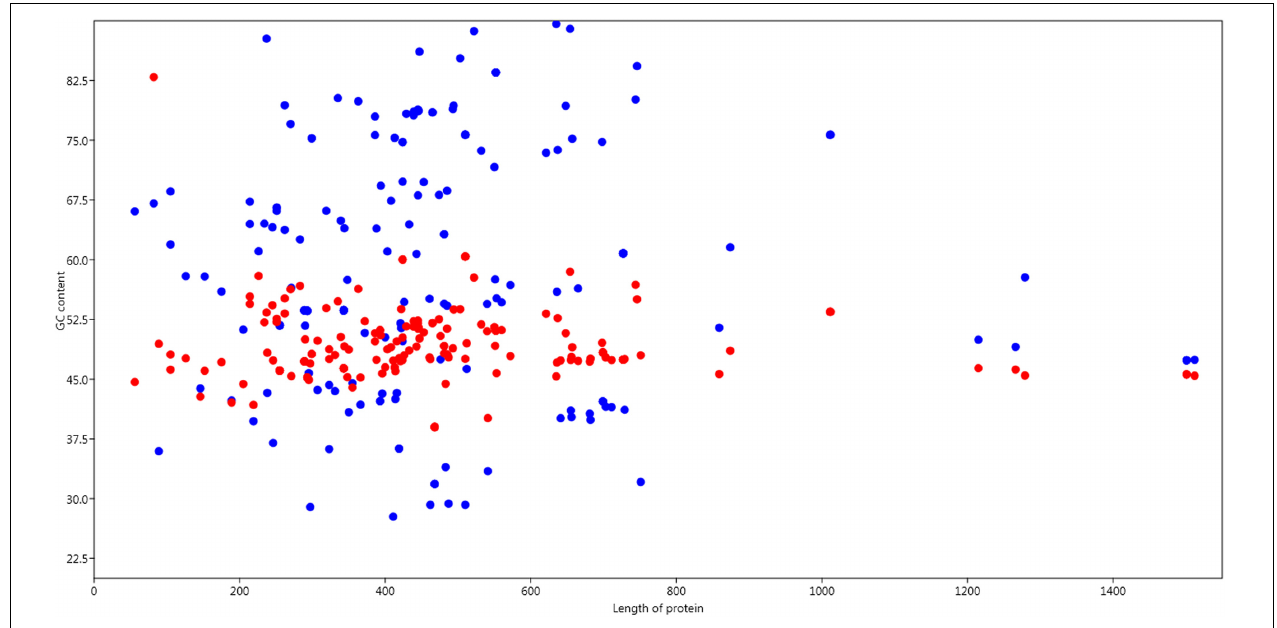
FIGURE 2 | Relation of GC content GC12 and GC3 with the length of the protein. Red dots are GC12 composition and blue dots are GC3 position.